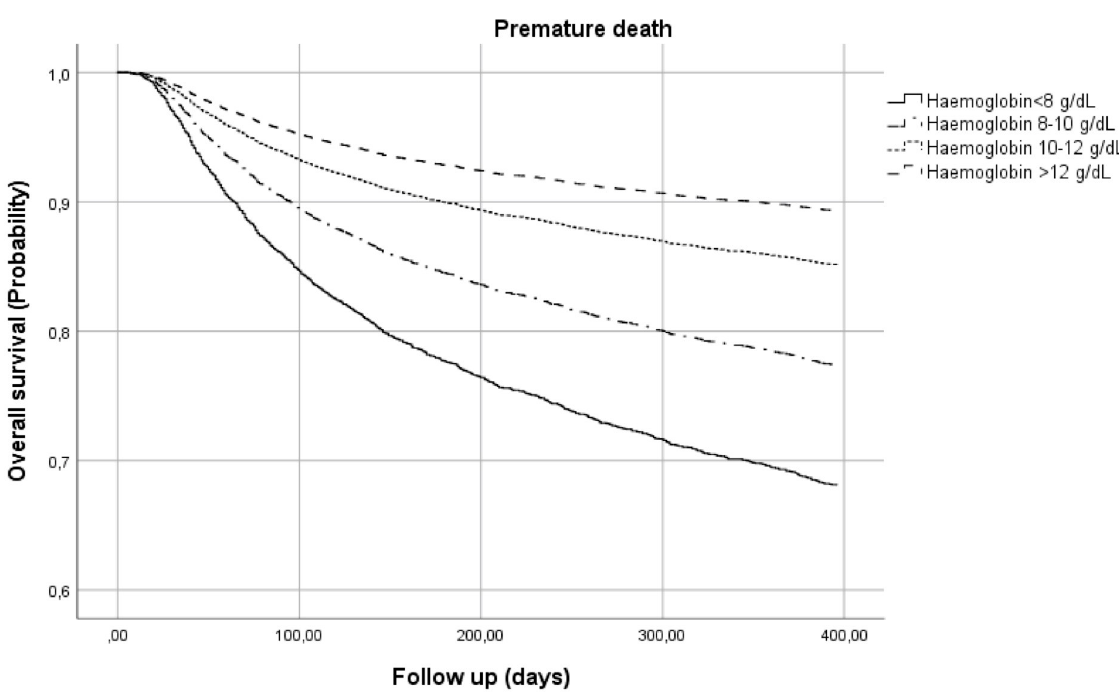
Fig 2. Risk of premature death by haemoglobin class.